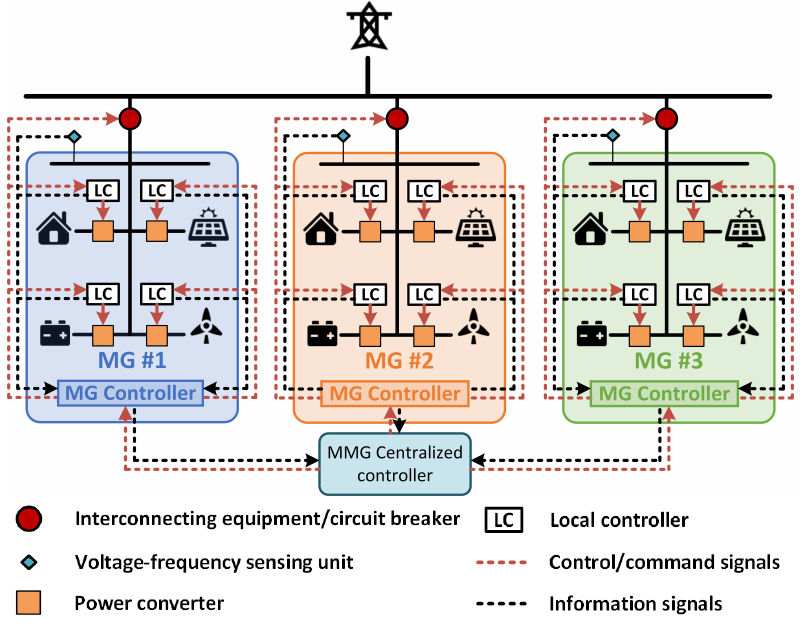
Figure 2. Centralized control